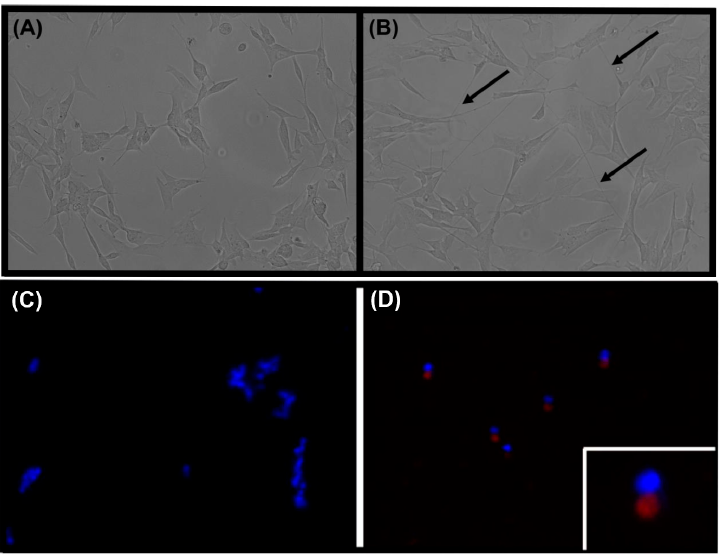
Figure 1. Microscopic images of native and differentiated SH-SY5Y cells under transmission Panels ( A , B ) and immunocytochemistry for Tyrosine Hydroxylase Panels ( C , D ) to confirm the anticipated dopaminergic phenotype. Cultured SH-SY5Y cells were exposed to ( A ) sterile H 2 O (vehicle control) or ( B ) RA and TPA ( B ) to initiate differentiation as described in the Methods section. After 7 days, images were captured using the EVOS FLoid Cell Imaging Station and are representative of n = 3 independent cell cultures. ( A ) Undifferentiated SH-SY5Y cells exhibited growth in multilayered clumps and lacked axonal growth. In comparison, ( B ) differentiated SH-SY5Y cells featured long dendritic processes (identified with arrows) and evenly distributed growth in a distinct monolayer typical for neuronal-like cells. The presence of tyrosine hydroxylase (red fluorescence) in native ( C ) and differentiated ( D ) cells was assessed by immunocytochemistry using a polyclonal anti-TH antibody. Cell nuclei were counterstained with DAPI (blue fluorescence). Images were captured at 20 × over 5 different fields per slide and are representative of at least 5 fields of view using n = 2 independent cell culture experiments. Inset in panel ( D ) shows a computer magnified image of a TH positive cell indicating the expression of this dopaminergic phenotypic